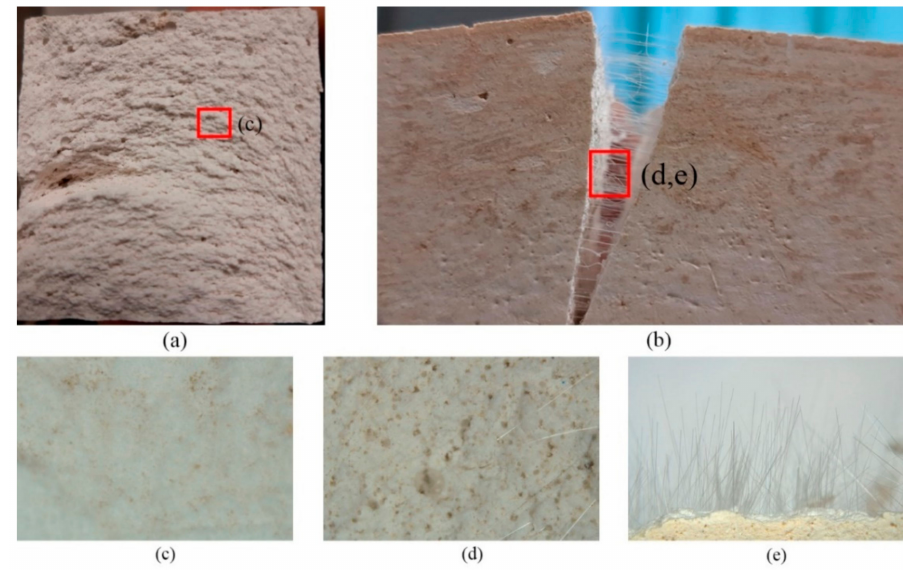
Figure 8. Specimen type D1 ( a ) and D1-PPF ( b ) and different images taken by light microscope ( c – e ).